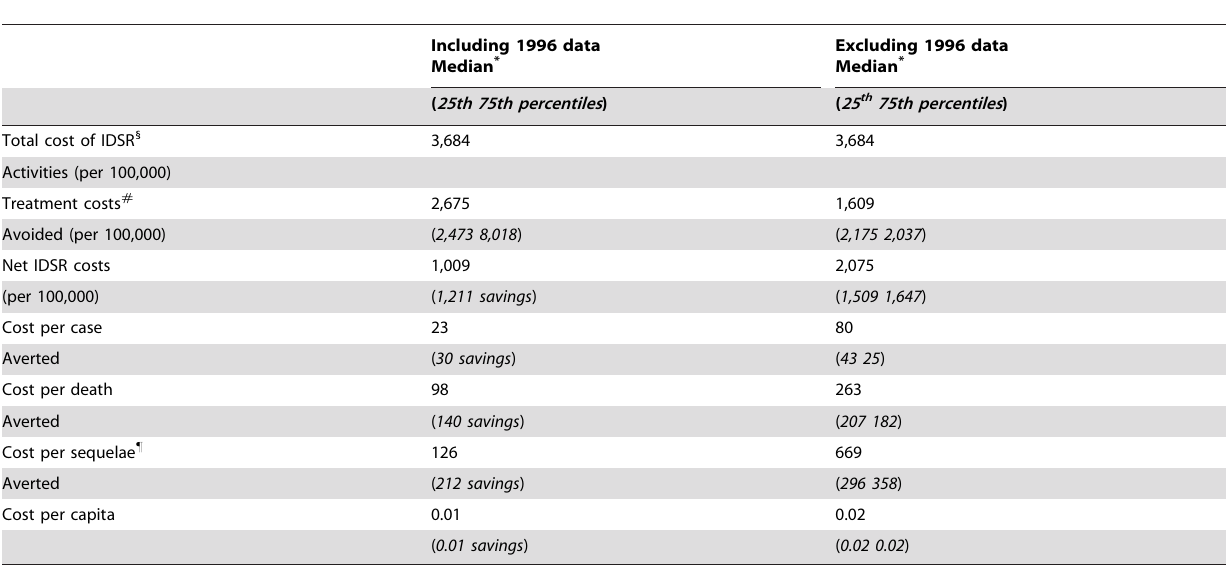
Table 2. Cost-effectiveness (2002 US $ ) correlated with IDSR impact on meningitis cases and deaths averted per outbreak in Burkina